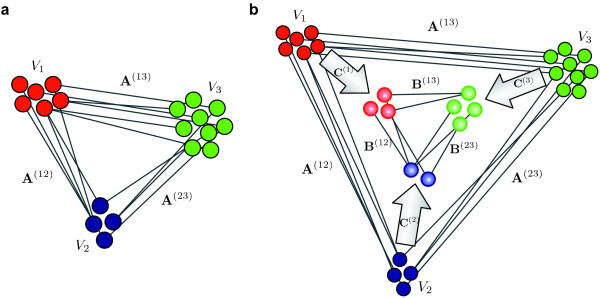
Illustration of the fuzzy clustering approach. We want to approximate the tripartite example graph G in (a) by a smaller tripartite cluster network H, the so-called backbone graph (b). The decomposition into fuzzy clusters connected by this backbone must explain the original connectivity as good as possible. The edges of G are collected in adjacency matrices A(ij) connecting the elements of the partitions i and j. The approximation of G by the backbone graph is encoded in the adjacency matrices B(ij) connecting the fuzzy node clusters C(i). These matrices C(i) collect the degrees of membership of each node of partition Vi to each cluster of this type. Its (k, l)-th element Ckl(i) specifies how much node k belongs to the backbone node l.